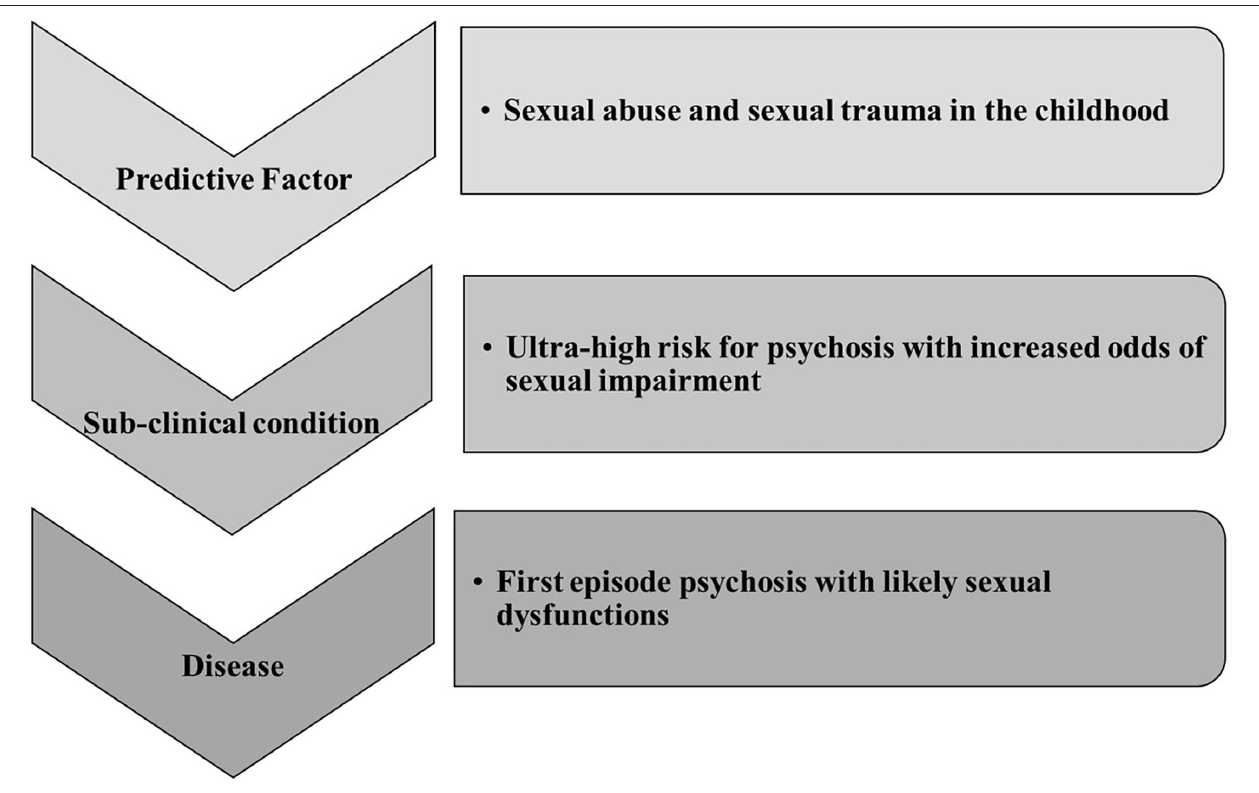
FIGURE 2 | Our literature review is summarized in this figure showing the sexological trajectory of psychosis. It is based on literature finding mainly focused on sexual abuses experience. Sexual trauma can be considered a central etiological factor for UHR, FEP, and then psychosis. However, major clinical and research attention should be posed to sexual impairment during the UHR